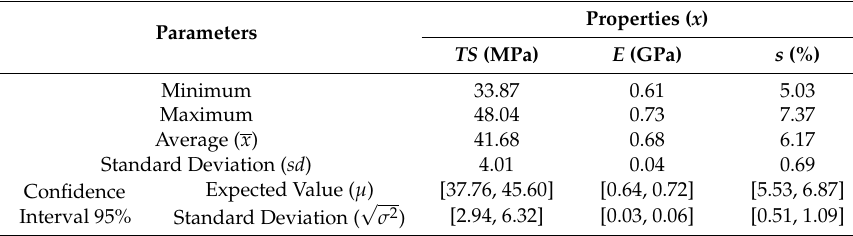
Table 2. Statistical